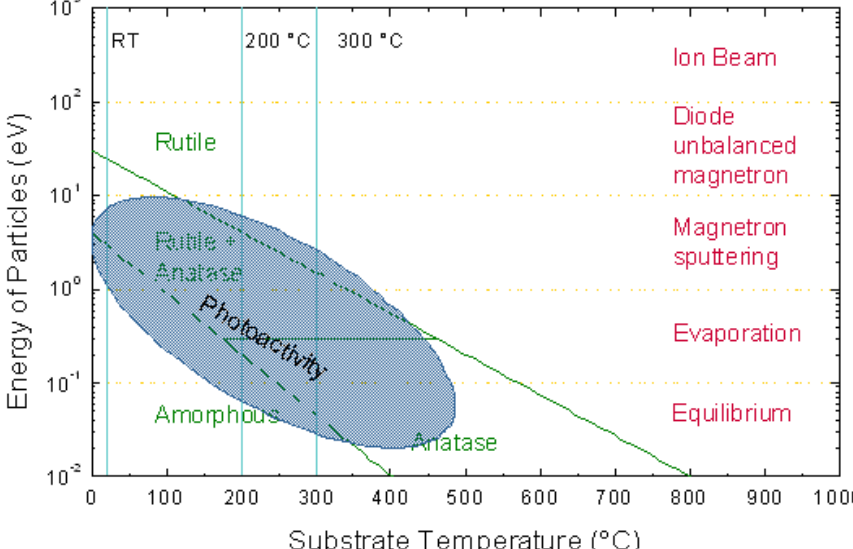
Figure 14 . Identification of process window to obtain different phases as a function of substrate temperature and particle energy. Additionally, the region allowing photoactive thin films is indicated by the blue shaded region